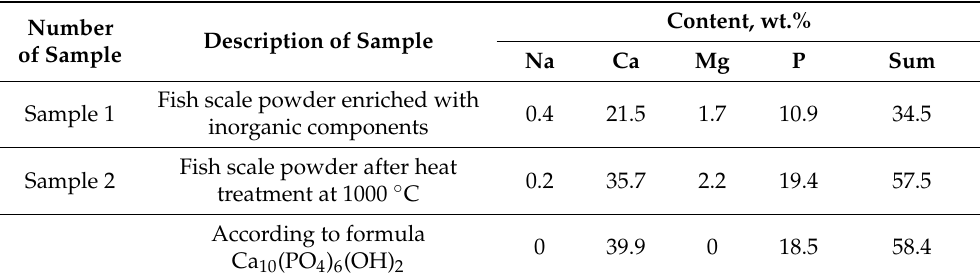
Table 2. Chemical analysis data of fish scale powder enriched with inorganic components before (sample 1) and after (sample 2) heat treatment at 1000 ◦